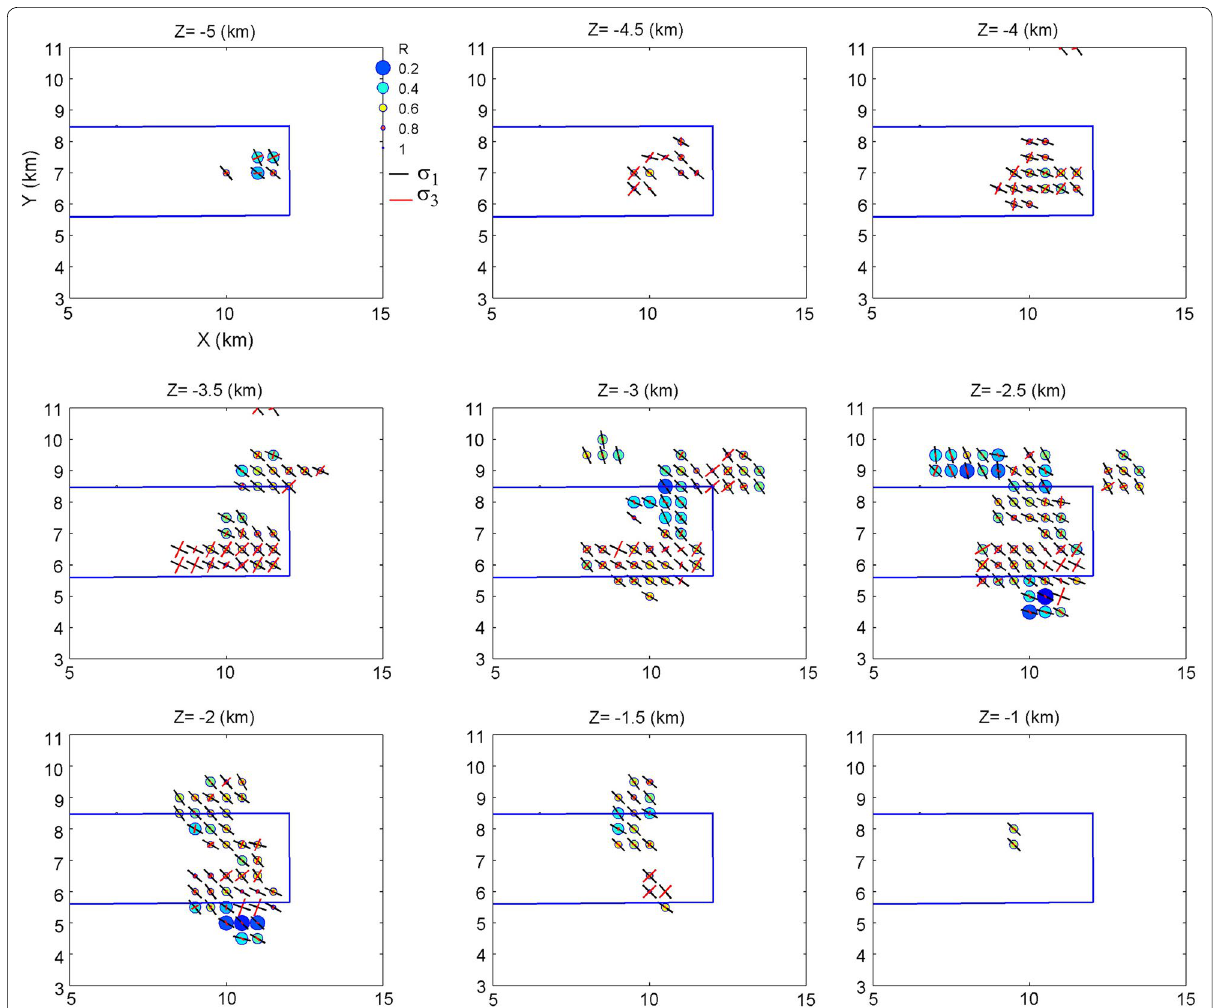
Fig. 5 Results of stress inversion projected onto horizontal planes. The maximum ( σ 1 ) and minimum ( σ 3 ) compressional stress axes are shown by black and red lines, respectively. The stress ratio R is shown by the dimensions and colors of filled circles. Blue rectangle is the earthquake fault estimated by Yoshida and Koketsu (1990). The coordinates are the same as those in Fig.